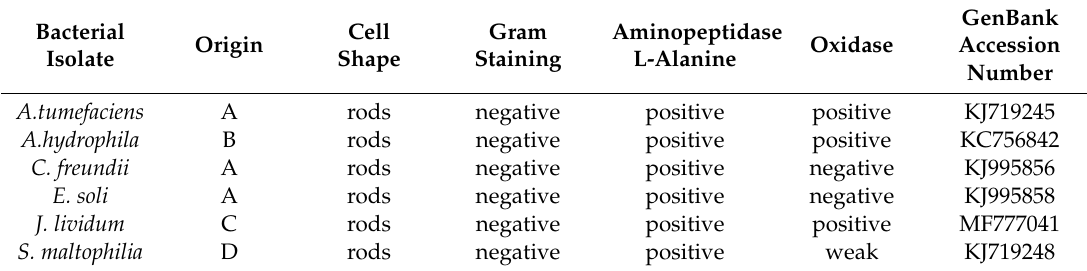
Table 1. Bacterial strains isolated from biofilms formed in drinking water systems.